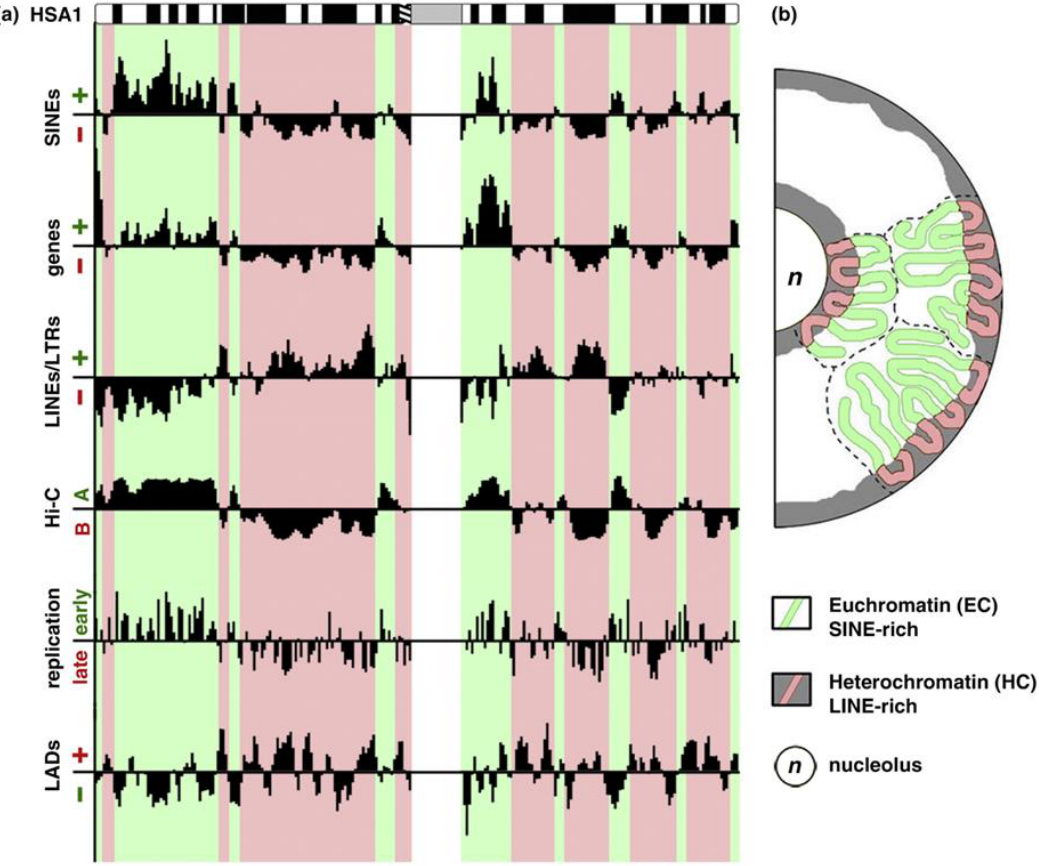
Figure 1. Euchromatic and heterochromatic chromosome regions and their spatial separation in the nucleus. ( a ) Euchromatin (EC) and heterochromatin (HC) domains revealed by different approaches showing the principal components and differential replication timing. ( b ) EC resides in the nuclear interior, whereas HC localizes to the nuclear and nucleolar periphery. A scheme is republished from [14], Figure 1, with the licence provided by Elsevier and Copyright Centre.